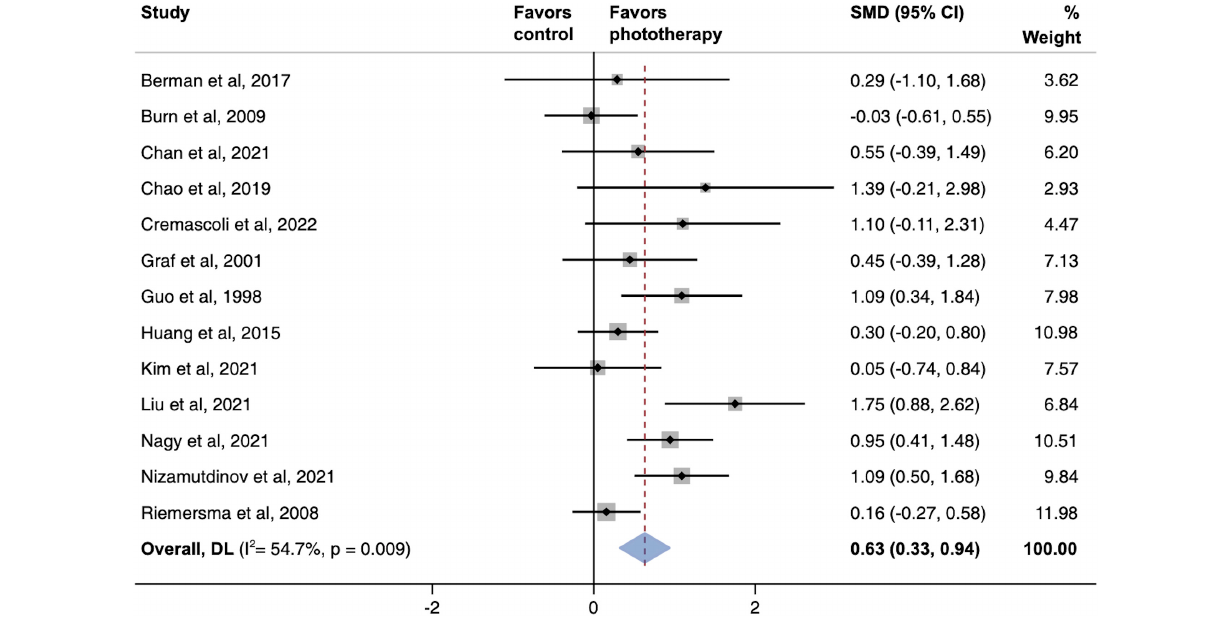
FIGURE 2 | Pooled effects of global cognitive function changes after phototherapy as compared to control interventions. SMD, standardized mean difference. Weights are from random-effects